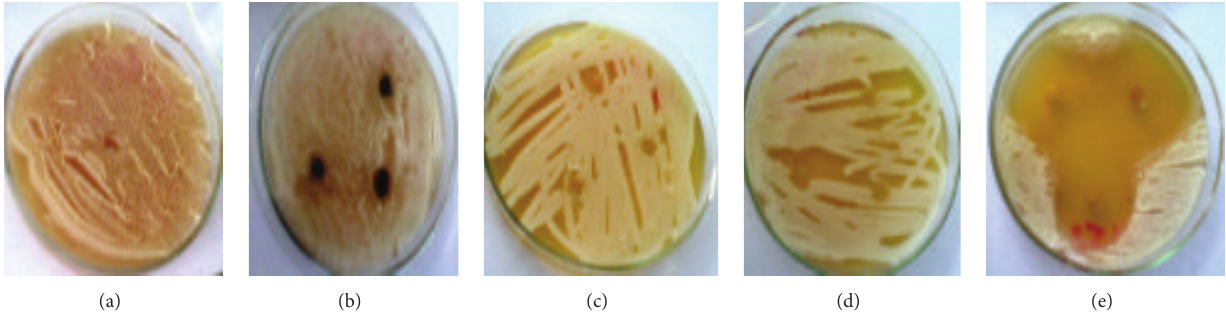
Figure 3: Growth inhibition zone on Trichophyton spp2 ((a) = DMSO, (b) = Matricaria chamomilla , (c) = Rosmarinus officinalis , (d) = Eucalyptus globulus , and (e) = Thymus schimperi ).